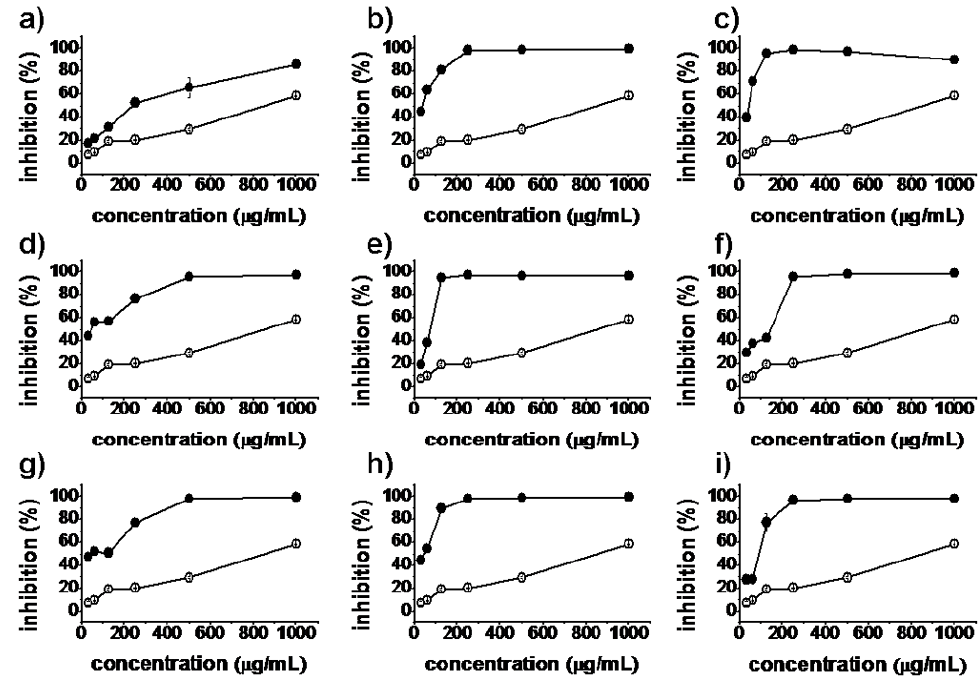
Figure 3. Inhibition percentages of 5a – i ( a – i , respectively) against A549 cells at concentrations of 31.25, 62.5, 125, 250, 500, and 1,000 μ g/mL. Matrine ( ), synthesized compounds ( ). Results are expressed as the mean ± SD of data obtained from three independent experiments.